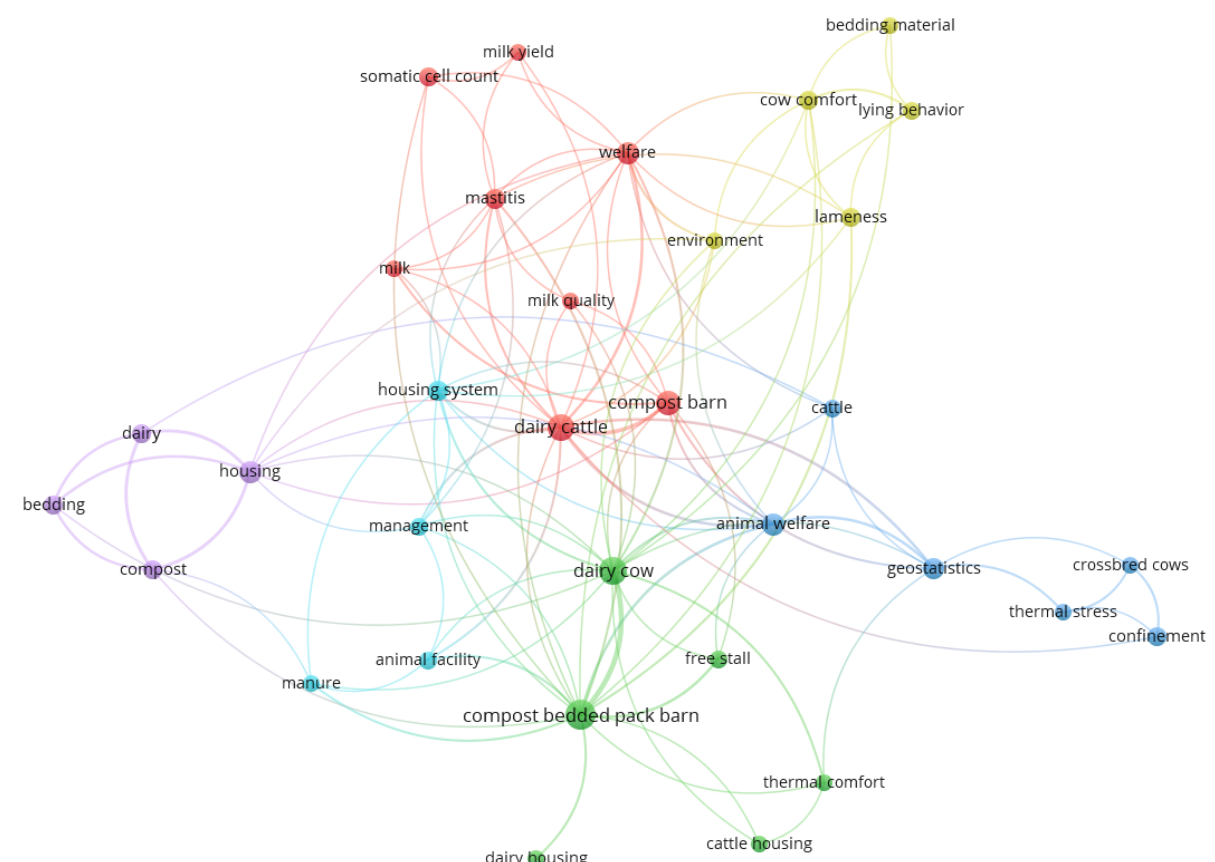
Figure 7. Network map between author keywords. Lines indicate co-occurrences between terms.